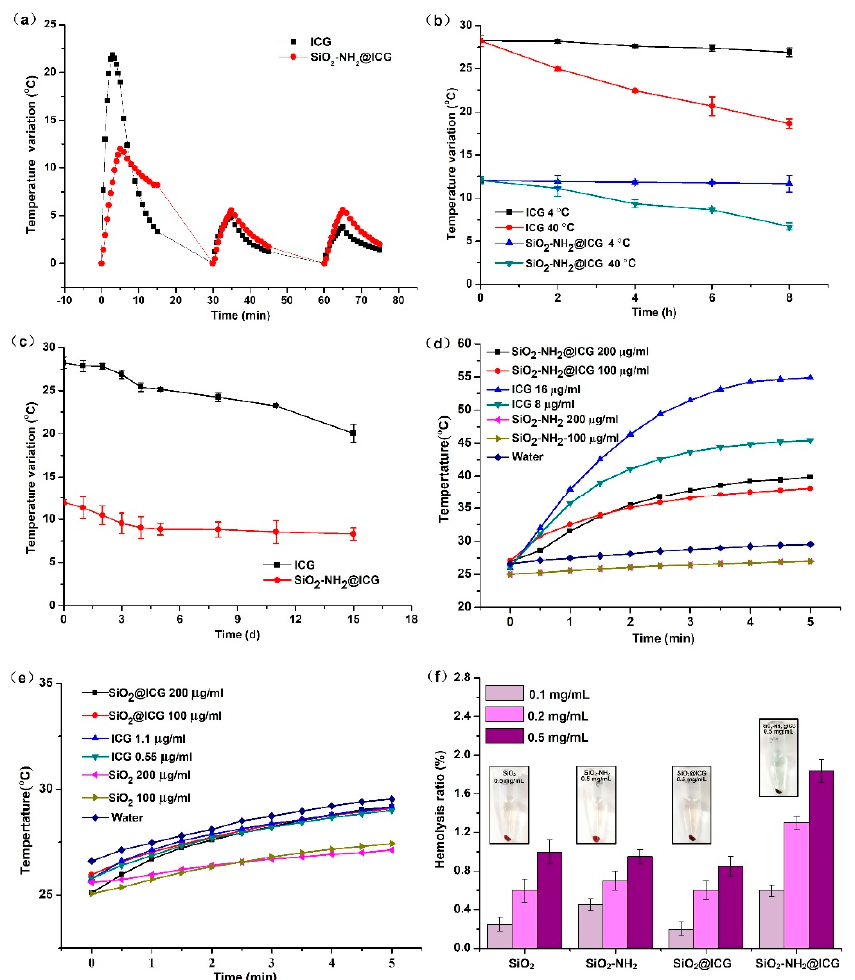
Figure 5. ( a ) Irradiation stability of SiO 2 -NH 2 @ICG. ( b ) Thermal stability of SiO 2 -NH 2 @ICG. ( c ) Long-